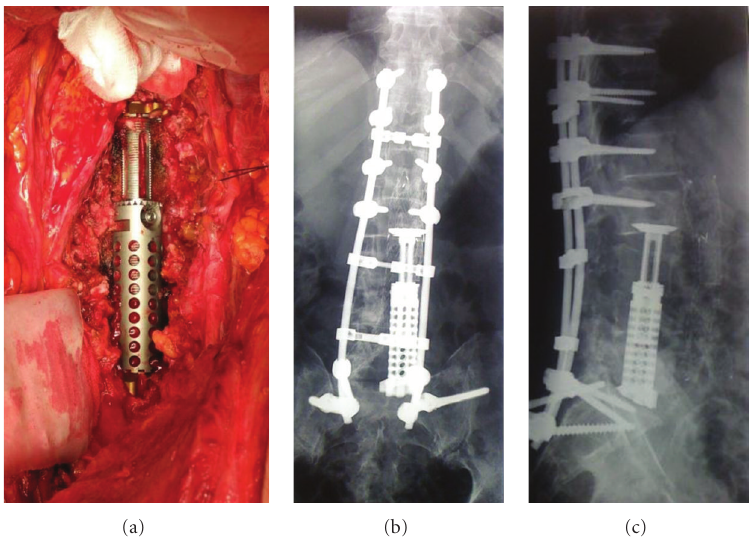
Figure 2: (a) Intraoperative picture showing the placement of the expansion mesh. ((b) and (c)) Follow-up pictures taken 12 months apart. They show the correct placement of the fixation system. The mesh is in place with a 3mm settling. To be noted here is the natural inclination of the mesh on the inferior end plate. This has allowed for restitution of a partial lordosis to the lumbar-sacral column.